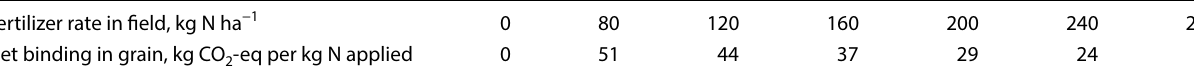
Table 4 Estimated amount of carbon dioxide bound in winter wheat grain, i.e., carbon sequestration, at different levels of mineral nitrogen fertilizer (yield with zero fertilizer (basic yield)